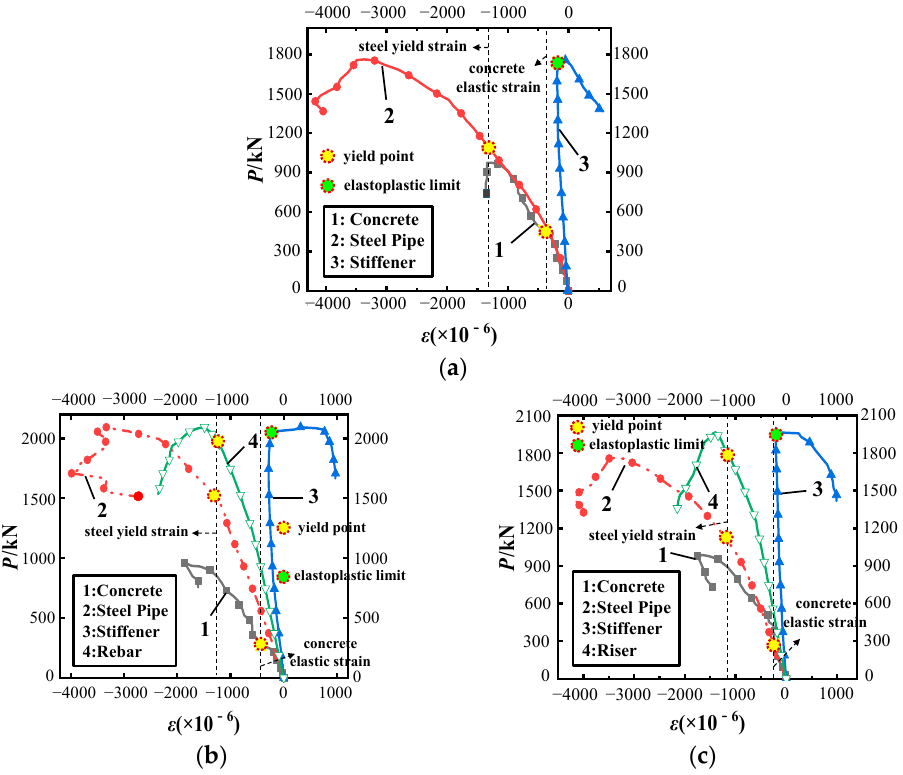
Figure 14. Load–strain relationship curves. ( a ) Specimen Z2; ( b ) Specimen Z3; ( c ) Specimen Z4. For specimen Z3: In the elastic stage, the reinforcement, concrete, and steel pipe were jointly stressed; the strain in the spiral rib was small and plays a minor load-bearing role.